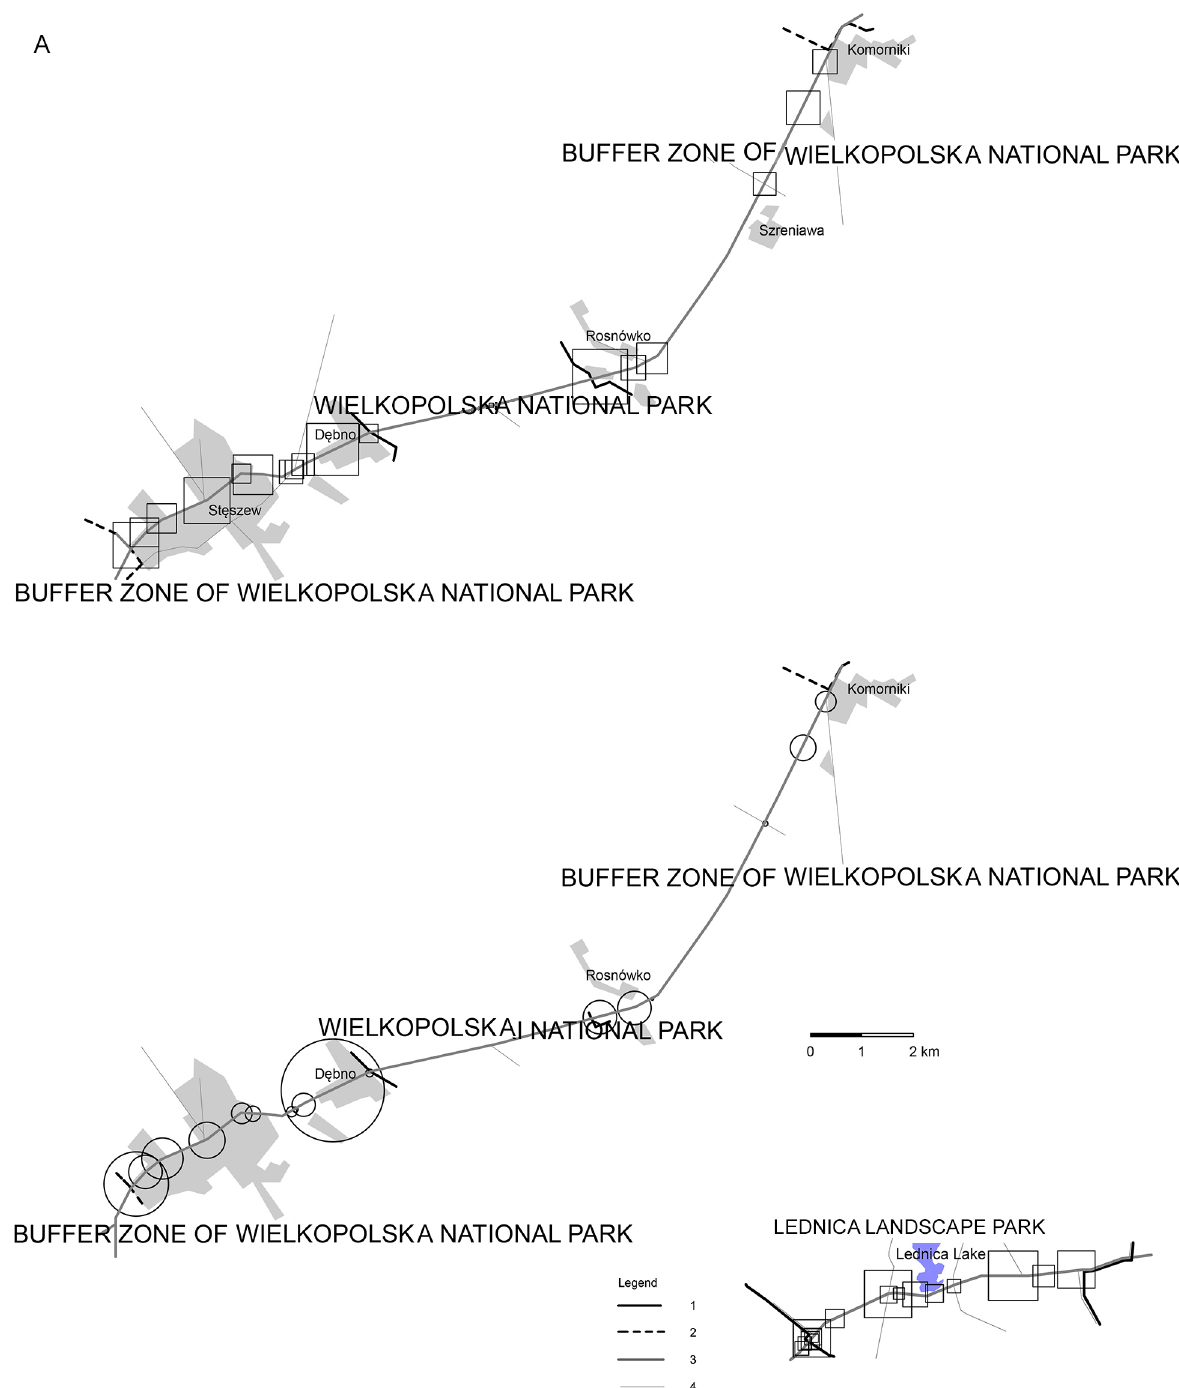
Fig. 3A–B. Concentration of advertisements along main roads in the analysed parks and their number and surface area: A – Wielkopolska National Park (WPN); B – Lednica Landscape Park (LPK). 1 – park area border; 2 – buffer zone border; 3 – main road; 4 – secondary road; 5 – water bodies Source: own